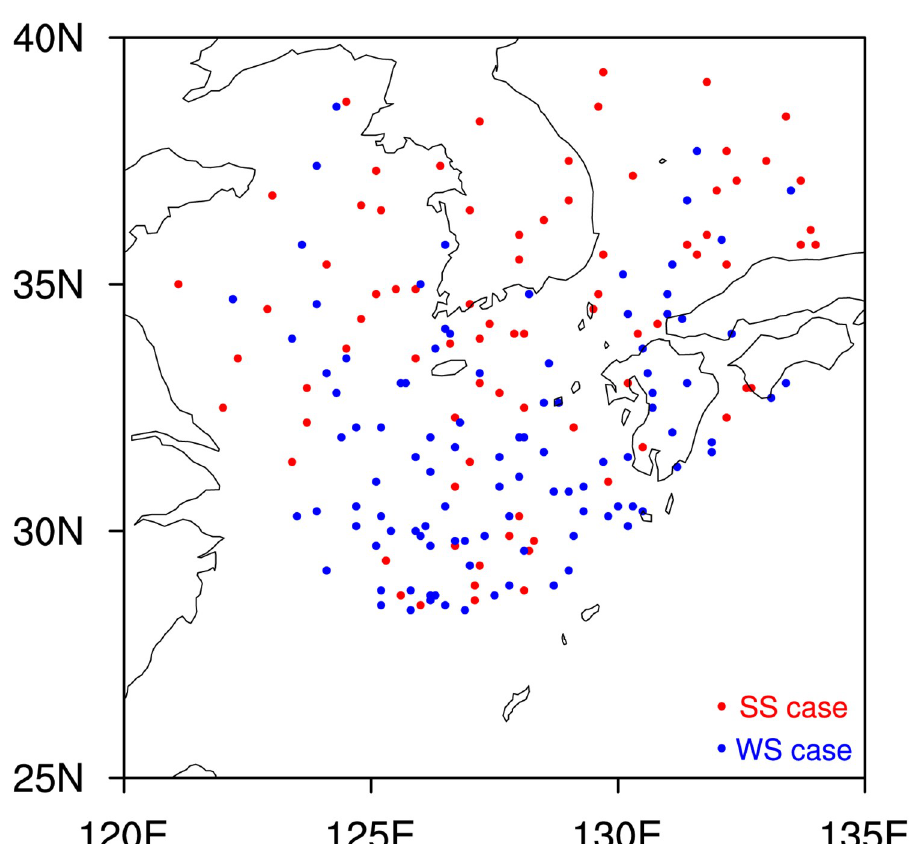
Fig 10. The distribution of TC center for the SS (red) and WS (blue)